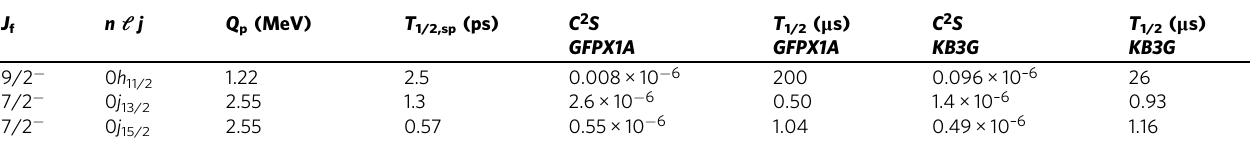
Table 1 Calculated properties of the proton-emission branches from the 10 + isomer in 54 Ni. They are calculated with the GXPF1A and KB3G